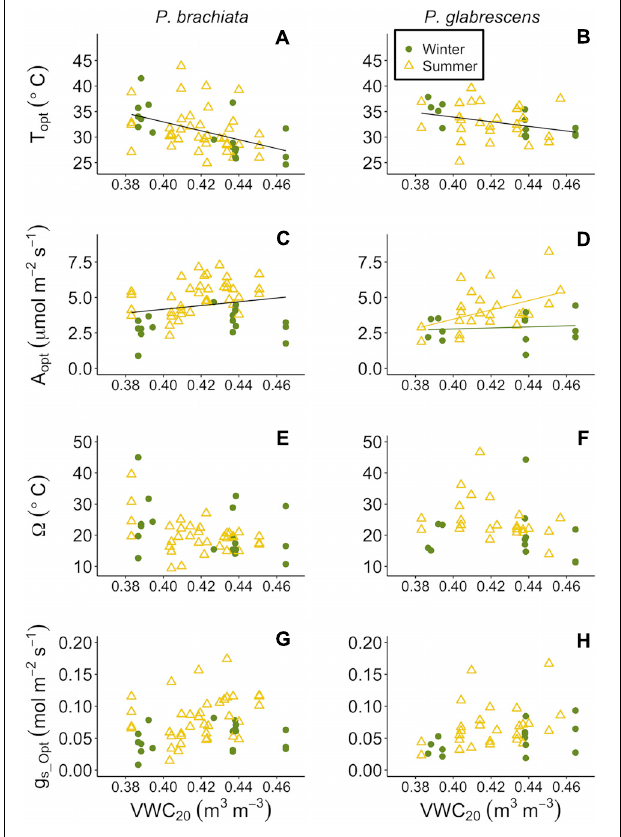
FIGURE 8 | Photosynthetic parameter responses to soil moisture at 20–30 cm depth ( VWC 20 ). (A) Psychotria brachiata optimum temperature of photosynthesis ( T opt ) response to VWC 20 of winter (green circles) and summer (yellow triangles), (B) Piper glabrescens T opt response to VWC 20 , (C) P. brachiata rate of photosynthesis at T opt ( A opt ) response to VWC 20 , (D) P. glabrescens A opt response to VWC 20 , (E) P. brachiata photosynthetic thermal niche ( (cid:127) ) response to VWC 20 , (F) P. glabrescens (cid:127) response to VWC 20 , (G) P. brachiata rate of stomatal conductance at T opt ( g s_Opt ) response to VWC 20 , and (H) P. glabrescens rate of stomatal conductance at T opt ( g s_Opt ) response to VWC 20 . Fit lines (green - winter; yellow – summer) indicate a significant interaction between VWC 20 and season ( Supplementary Table S7 ). A solid black line is fit when there is a significant VWC 20 response but no interaction ( Supplementary Table S7